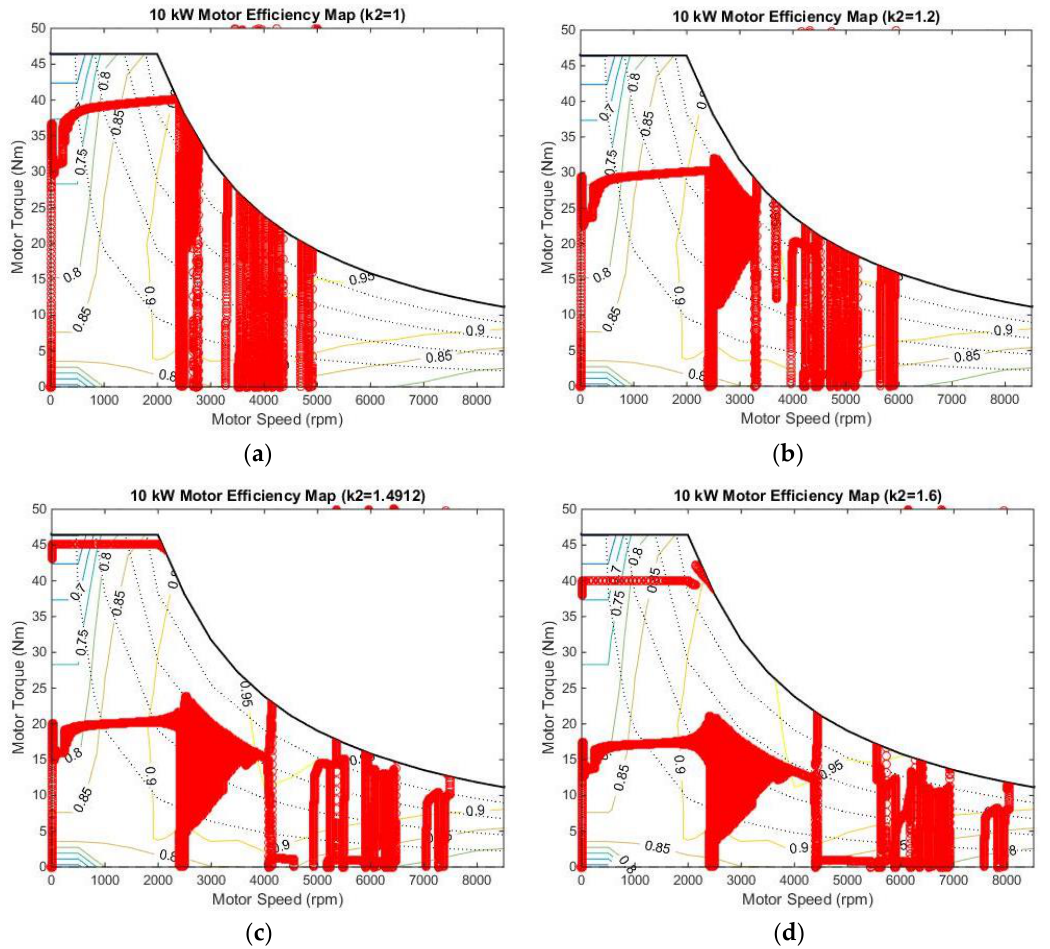
Figure 16. ( a ) Motor operation points (with 𝑘 2 = 1 ). ( b ) Motor operation points (with 𝑘 2 = 1 .2). ( c )